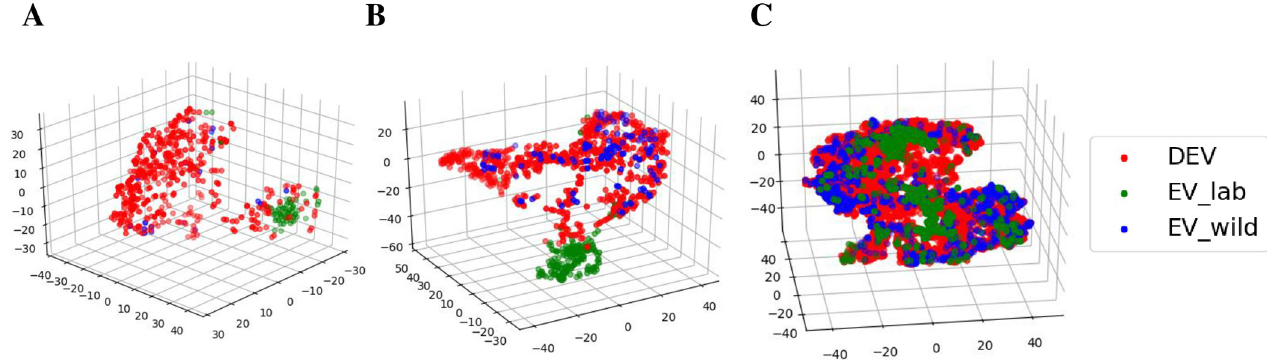
Fig 8. Scatterplots of USVs from three classes comparing different types of data and mice. 3-dimensional t-distributed stochastic neighbor embedding (t- SNE) representation of the classes (A) ‘c’, (B) ‘ui’, and (C) ‘Rise’ are shown. Colors indicate the dataset to which USVs belong.